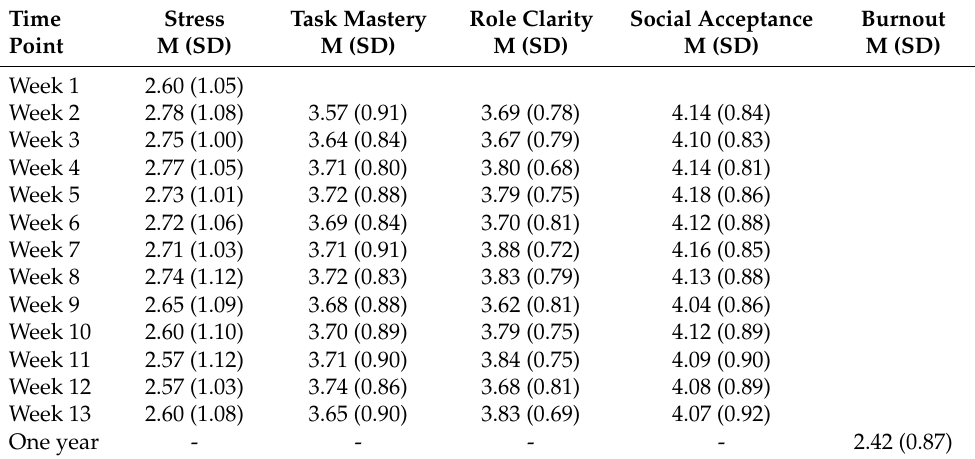
Table 2. Summary measures (means and standard deviations) of study variables week 1–13 ( n = 212–294) and one year into a profession ( n = 238).